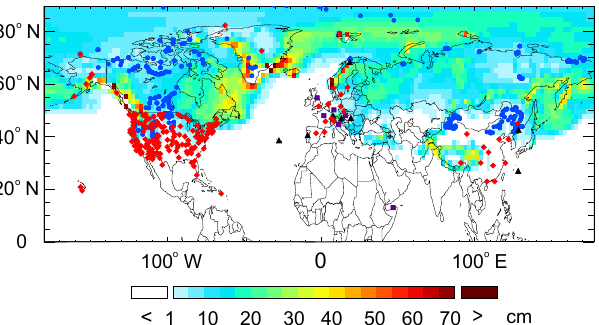
Figure 1. BC measurements used in this study: scavenging efficien- cies (purple squares), concentration in air (red diamonds), concen- tration in snow (blue circles), washout ratio (black triangles), and average snow depth (cm) for 2006–2012 (color